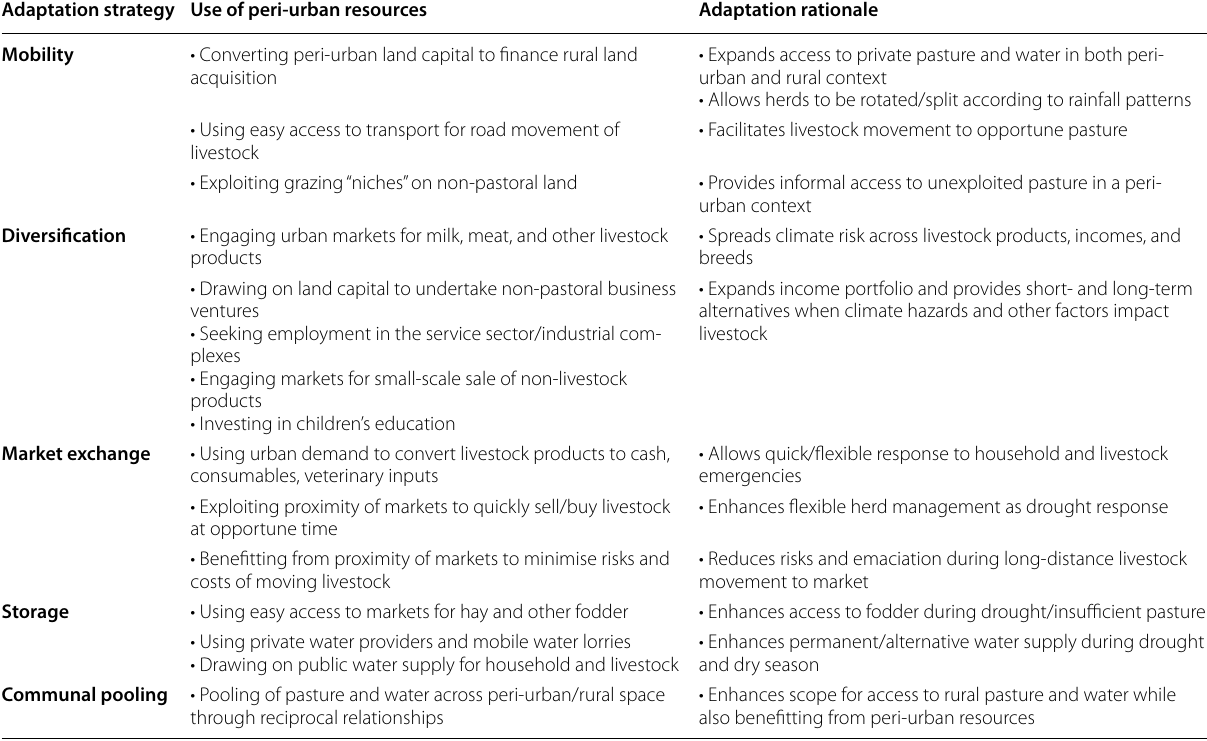
Table 3 Pastoralist’s use of peri-urban resources in adaptation strategies Adaptation strategy Use of peri‑urban